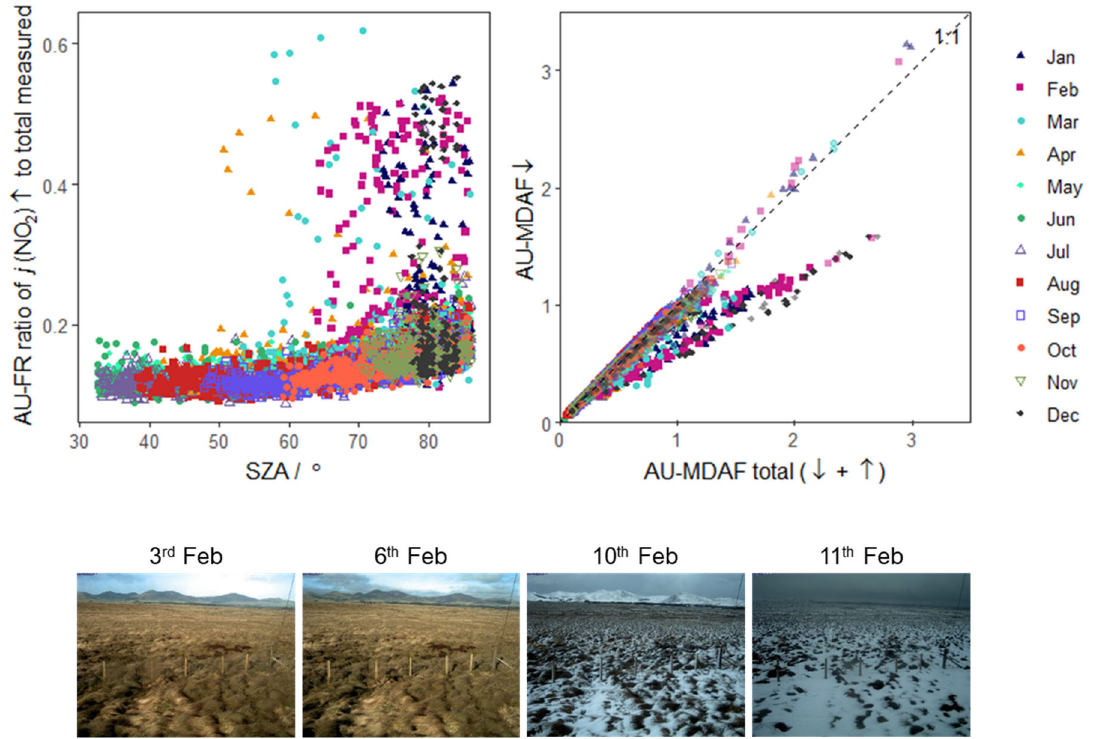
Figure 7. ( Left ): ratios of hourly mean measured j (NO 2 ) upwelling ( ↑ ) to total ( ↓ + ↑ ) as a function of SZA at Auchencorth Moss. ( Right ): scatterplot of hourly mean MDAF values derived using only downwelling j (NO 2 ) against values derived using total j (NO 2 ) ( ↓ + ↑ ). ( Below ): example photos of the site, taken by an automatic Phenocam (EuroPhen) at 12:00 UTC, for 3 and 6 February with no snow, whose hourly data lie on the 1:1 line in the right panel, and on 10, 13 February with snow, whose hourly data lie on the relationship below the 1:1